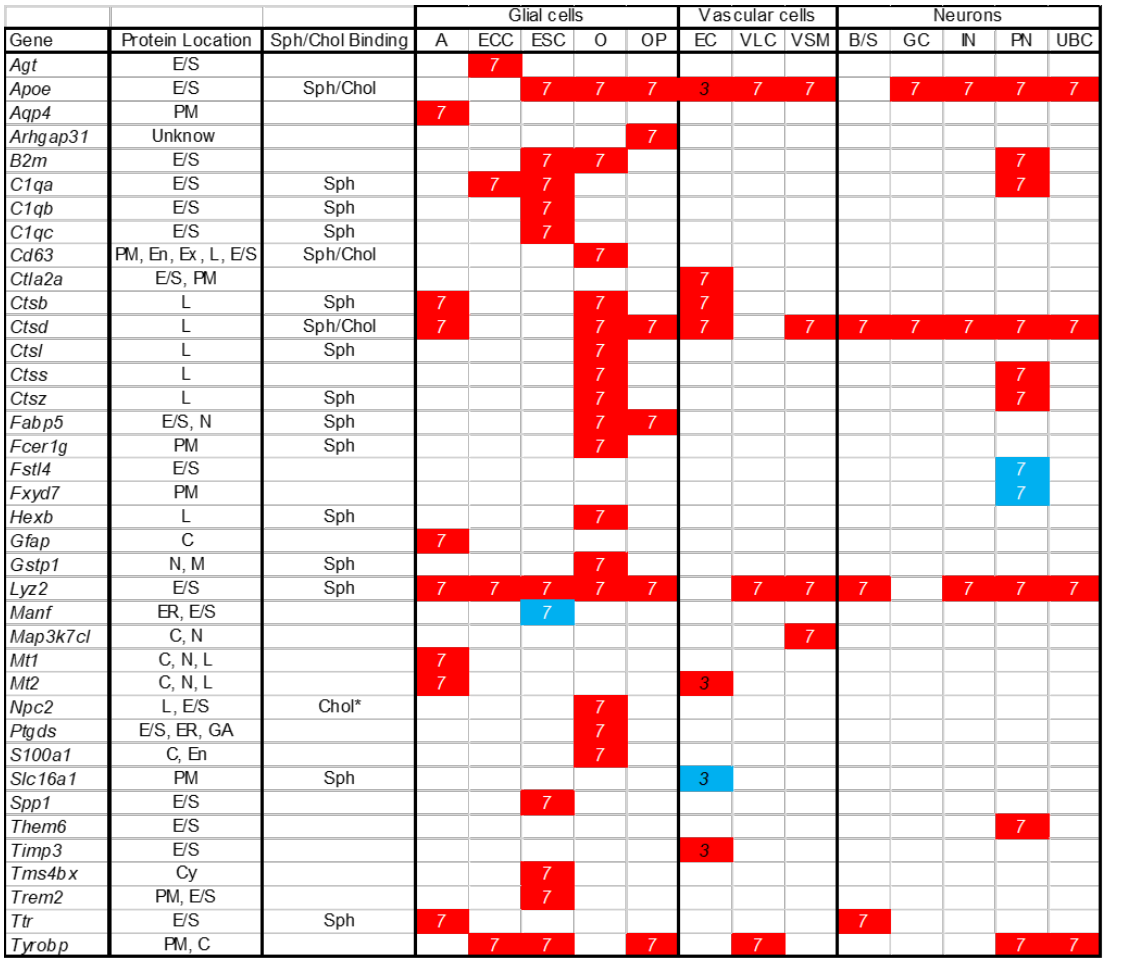
Figure 8. Single cell expression data for 38 differentially expressed gene. Increased (red) and decreased (blue) at both three and seven weeks is indicated for specific cell types. A: astrocytes; ECC: ependymal ciliated cells; ESC: ependymal secretory cells; O: oligodendrocytes; OP: